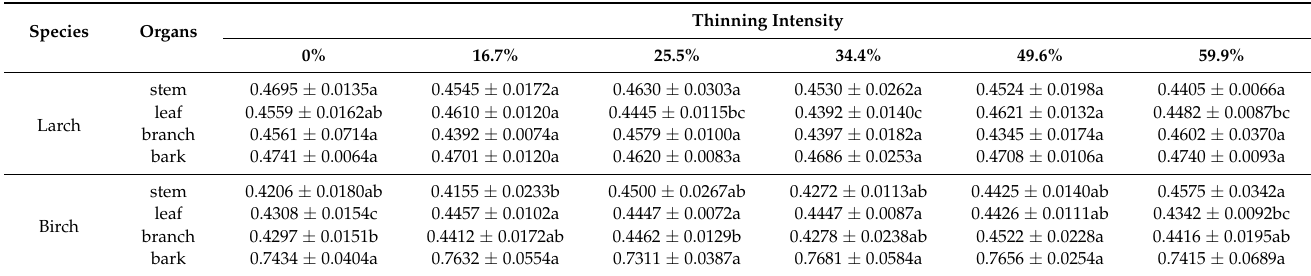
Table 4. Carbon content of organs of tree species under tending thinning intensity. Carbon content (g/g) = Mean +